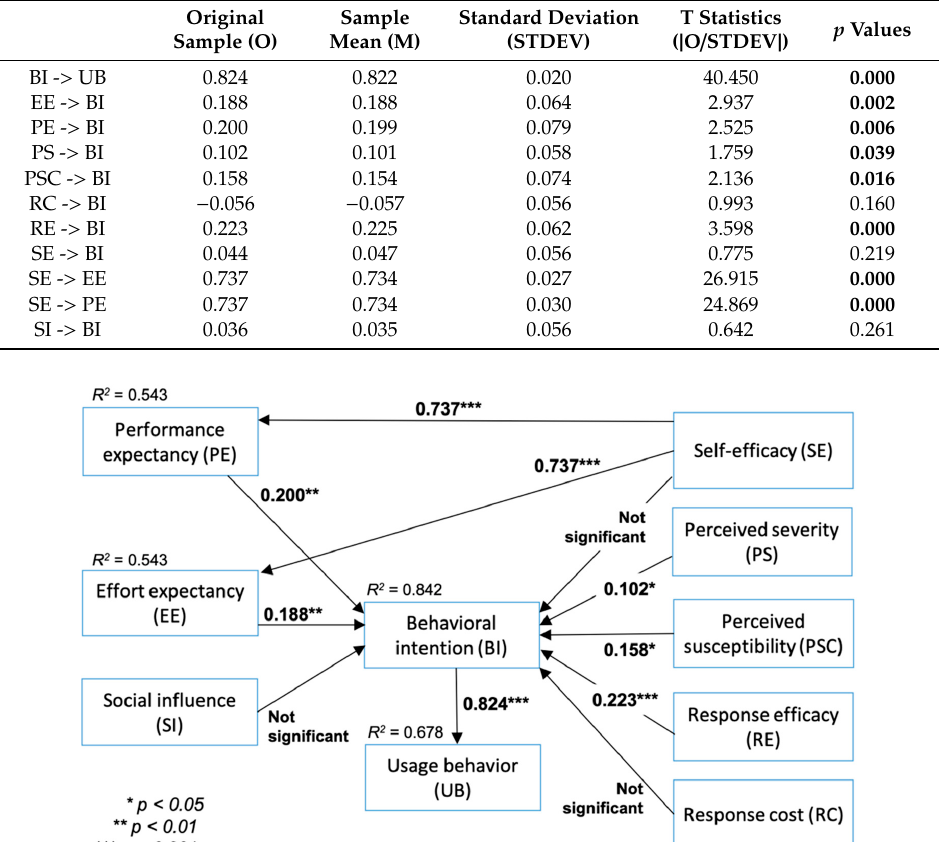
Table 6. The significance of the relationships in the model.